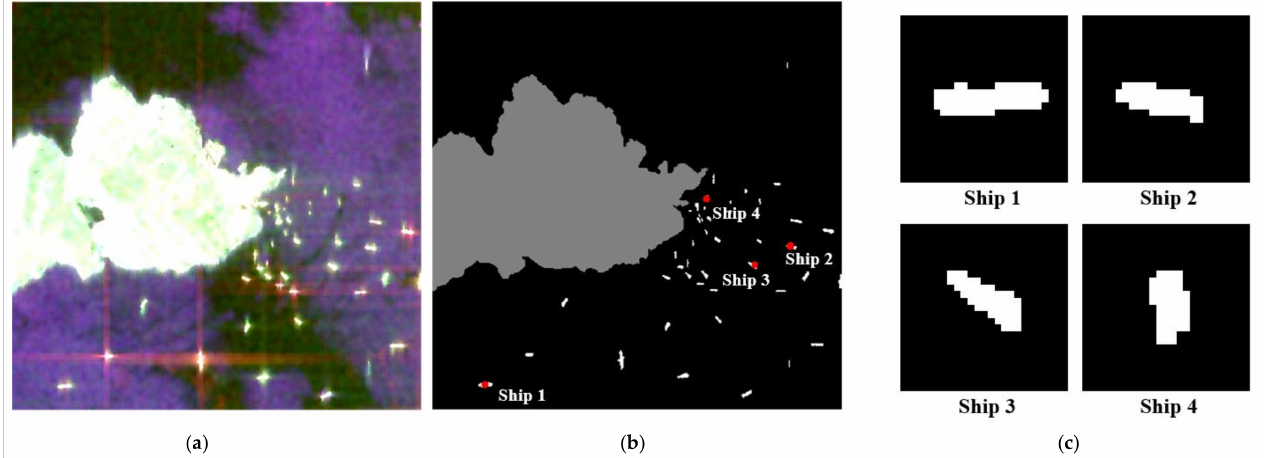
Figure 2. GF-3 PolSAR dataset. ( a ) Pauli RGB image. ( b ) Ground-truth image. ( c ) Ground-truth images of selected ship slices.